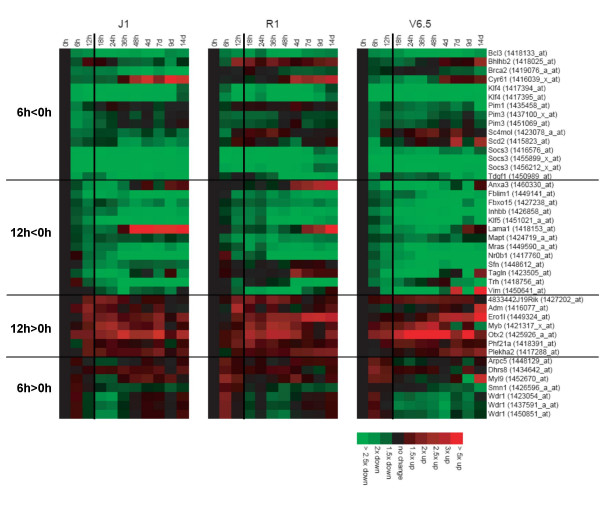
Signal values of 42 selected MOE430A probe sets in the three time series (R1, J1, and V6.5). Gene names and probe set identifiers are indicated on the left. Relative to their signal value at time 0 h, top 15 probe sets displayed a significant signal decrease at 6 h, next 13 displayed a significant signal decrease at 12 h, next 7 displayed a significant signal increase at 12 h, and bottom 7 displayed a significant signal increase at 6 h, in at least two of the three cell lines analyzed.